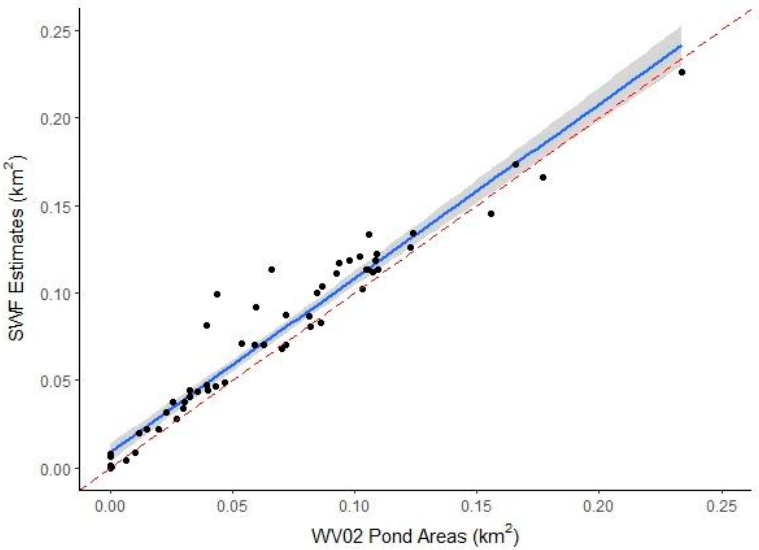
Figure 3. The sum of sub-pixel water fraction pixel values plotted against the sum of the area of manually-delineated waterbodies within 500 m 2 plots. The blue line represents the model predictions (SWF estimates ~ WV02 Pond Areas), the grey bar represents the 95% confidence interval, and the dotted red line shows a 1:1 relationship.